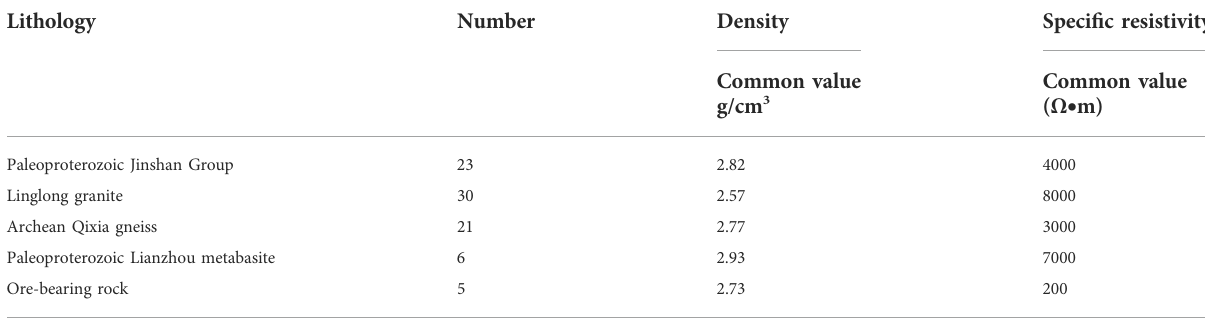
TABLE 1 Density and speci fi c resistivity data for the samples from the ore-bearing rocks and wall rocks in the Shanhou gold deposit.